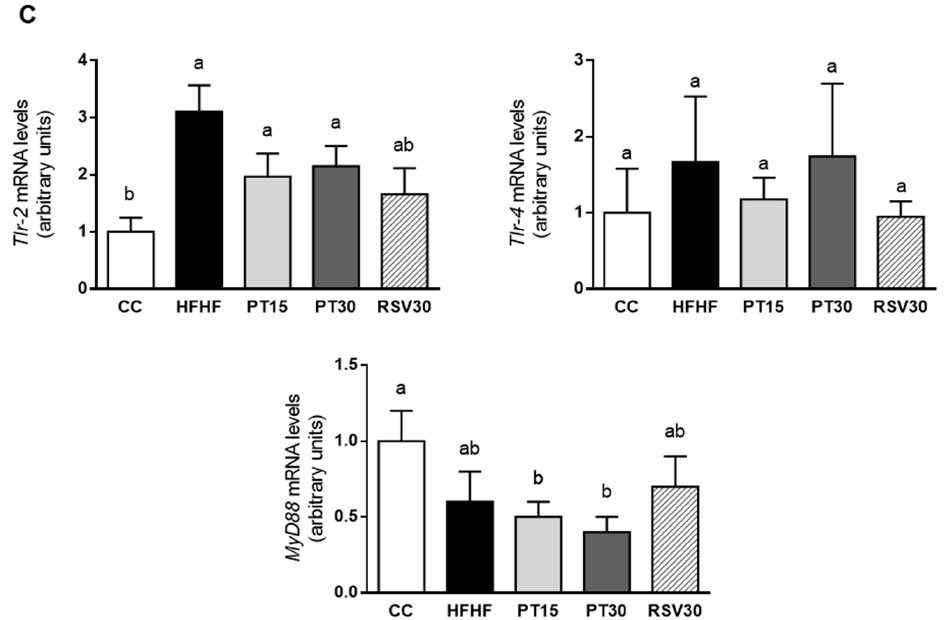
Figure 3. Il-1 β , Tnf α and Crp mRNA levels ( A ), F4 / 80 , Mcp1 and Cd206 mRNA levels ( B ) and Tlr-2 , Tlr-4 and MyD88 mRNA levels ( C ) in the livers from the rats fed with a control diet (CC group), a high-fat high-fructose diet (HFHF group), a high-fat high-fructose diet supplemented with pterostilbene at a dose of 15 mg / kg body weight / d (PT15 group), a high-fat high-fructose diet supplemented with pterostilbene at a dose of 30 mg / kg body weight / d (PT30 group) or a high-fat high-fructose diet supplemented with resveratrol at a dose of 30 mg / kg body weight / d (RSV30 group). Values are presented as mean ± SEM. Bars not sharing common letters are significantly di ff erent ( p < 0.05). Il-1b : interleukin 1b; Tnf α : tumor necrosis factor α ; Crp : C-reactive protein; Mcp1 : monocyte chemoattractant protein 1; Cd206 : mannose receptor C; Tlr-2 and Tlr-4 : toll-like receptor 2 and 4; MyD88 : myeloid di ff erentiation factor 88 MyD88.